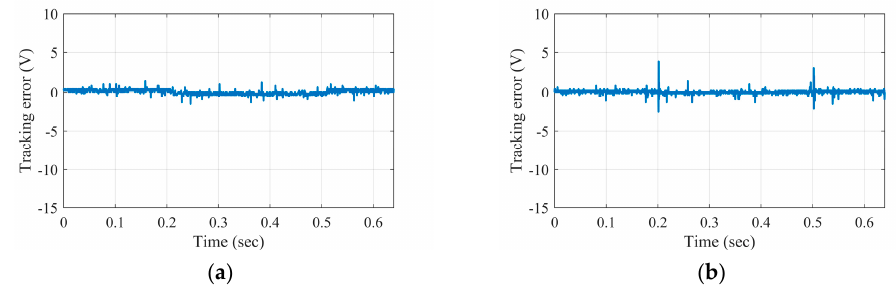
Figure 9. Output voltage tracking error in Case 2 with resistance load, ( a ) PI control, and ( b ) FTSM- ELM control.